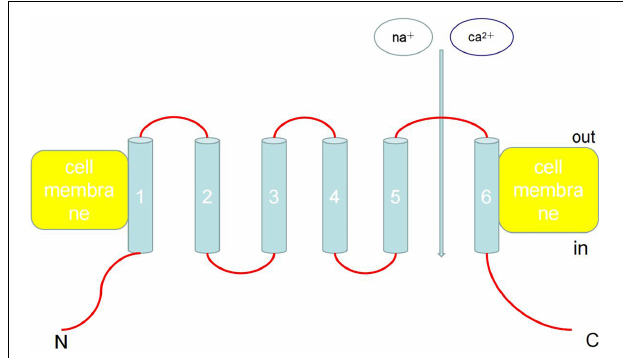
FIGURE 1 | Architecture of TRP channels. TRP can be activated by various physical and chemical stimuli and consist of six transmembrane helices (TM1-6), cytoplasmic N- and C-termini, and a pore area between TM5 and TM6. Ankyrin repeats are found in the amino termini of TRPC and TRPV channels. Currently, the functions and activation mechanisms of TRP family proteins are